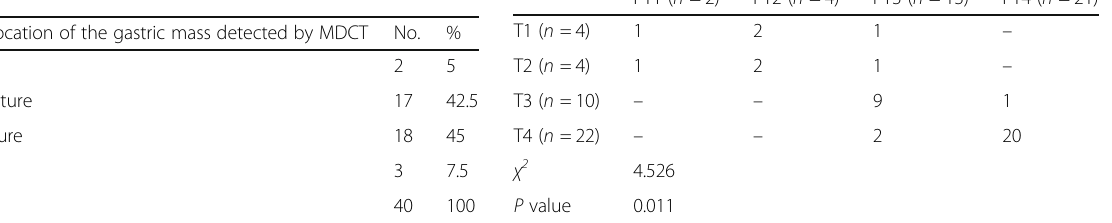
Table 4 Comparing the MDCT (T) stage with the pathological (T) stage CT